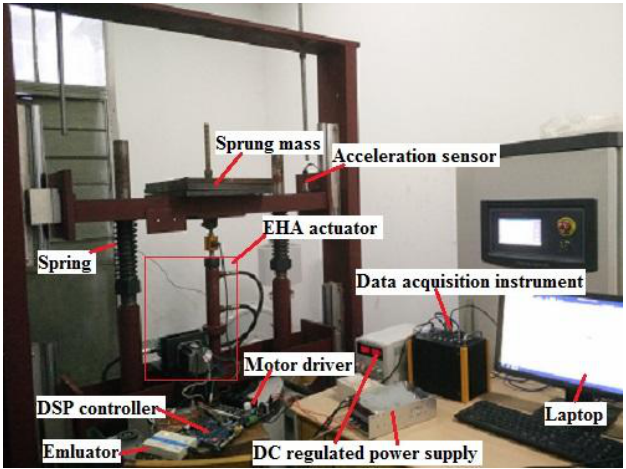
Figure 12. Bench test of EHA semi-active suspension system.